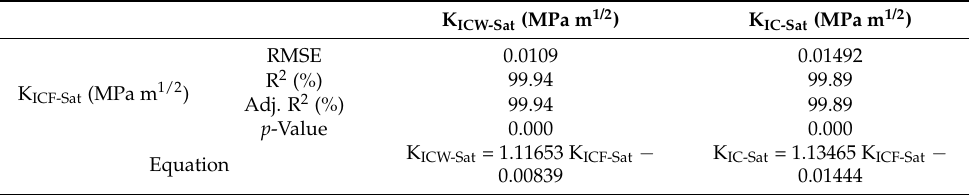
Table 5. Correlation among K IC determined from three different methods under a saturated state.